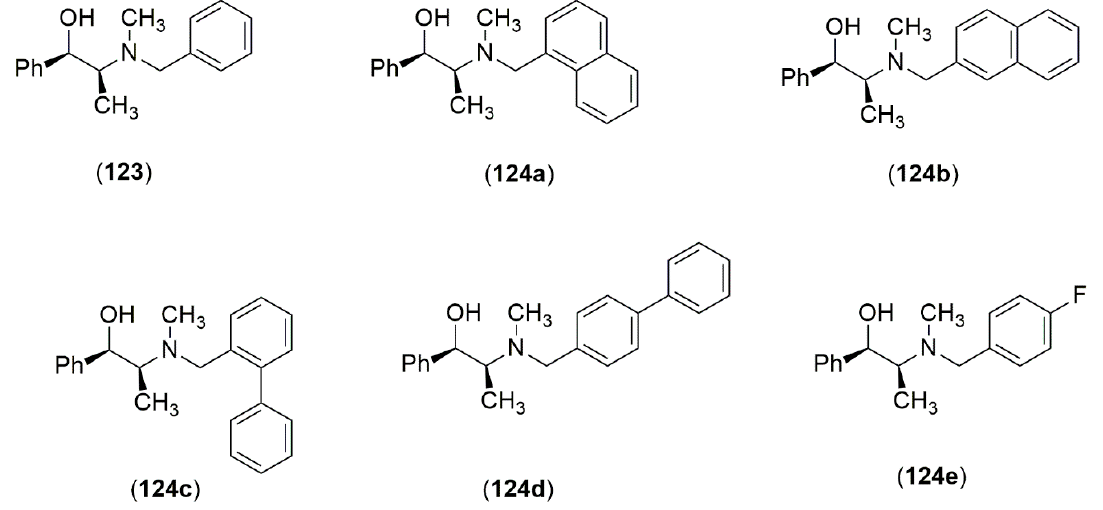
Figure 7. Aromatic motifs in the design of Ephedra ligands.